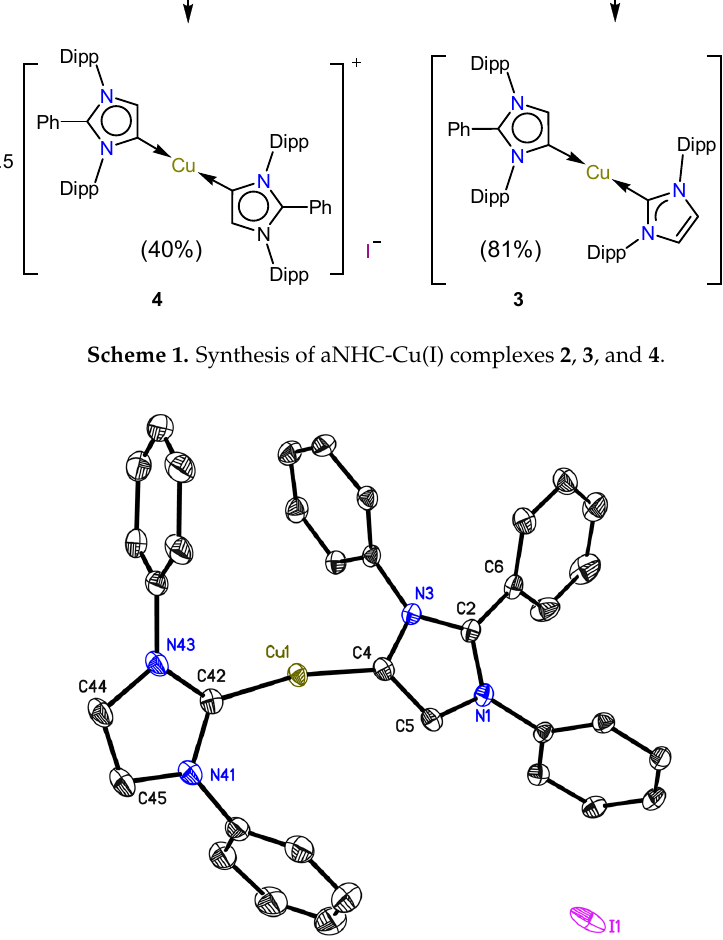
Figure 1. Molecular structure of [Cu(aIPr Ph )(IPr)]I ( 3 ). Anisotropic displacement parameters are depicted at the 50% probability level. Hydrogen atoms and isopropyl groups are omitted for clarity. Selected bond lengths (Å) and bond angles (°): C42–Cu1, 1.9041(19); C4–Cu1, 1.9005(19); C4–C5,